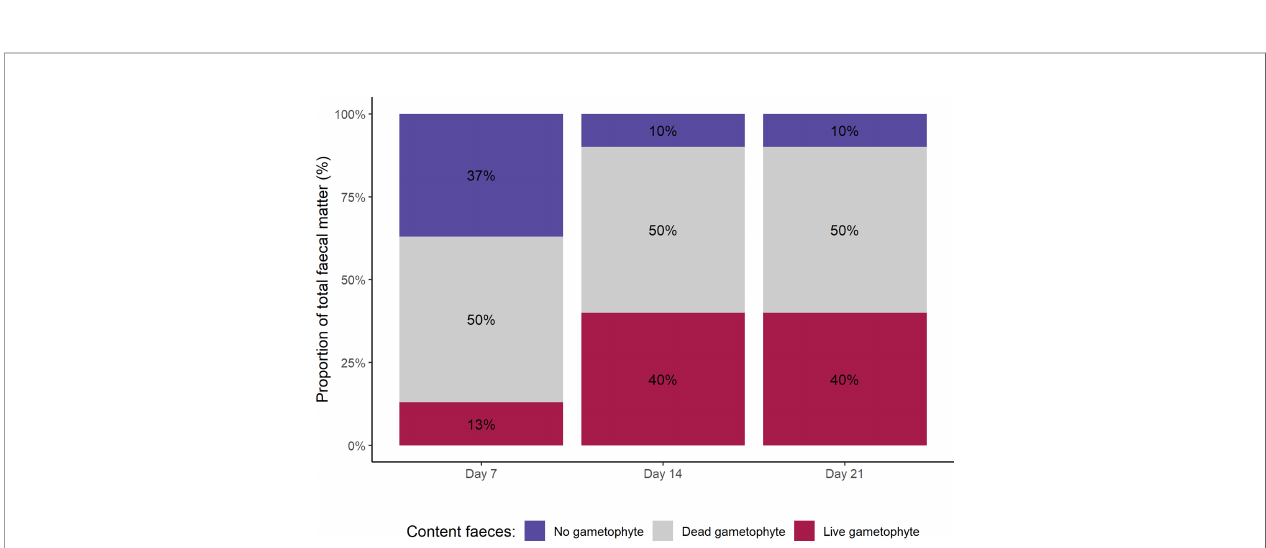
FIGURE 5 | Content of A. atkinsoni faecal matter after 7, 14 and 21 days of culturing faecal pellets. Separate faecal pellets ( n = 10) were examined at each time point and were categorised as containing no gametophyte, a dead gametophyte (i.e. no pigmentation) or a live gametophyte (i.e. pigments present).